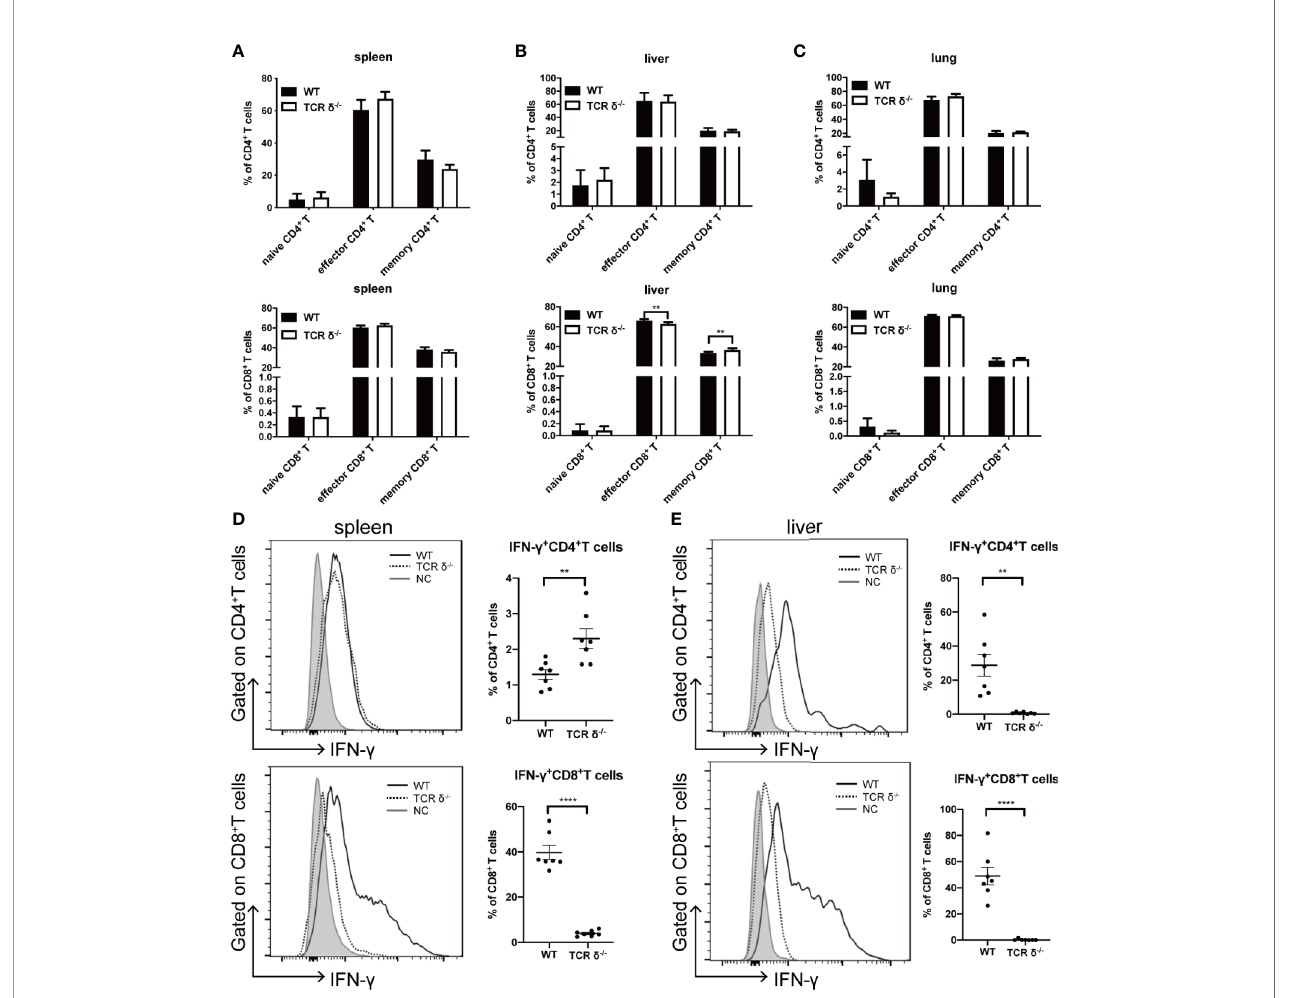
FIGURE 2 | Activation phenotypes and IFN- g production of CD4 + and CD8 + T cells in the recipients of WT or TCR d -/- grafts after allo-HSCT. The allo-HSCT was performed as described in Figure 1A . The lymphocytes were isolated from host spleen or liver on day 10 post allo-HSCT and analyzed by fl ow cytometry. Percentages of naïve, effector and memory CD4 + and CD8 + T cells in spleen (A) , liver (B) , and lung (C) were shown. The production of IFN- g by CD4 + and CD8 + T cells in the spleen (D) and liver (E) post allo-HSCT were examined (NC-Negative control: grey shaded, WT: solid line, TCR d -/- : dotted line). All data are representative of at least 3 independent experiments with n = 7 mice per group. All graphs display mean ± SEM. Signi fi cance was determined by unpaired 2-tailed Student ’ s t tests. ** p < 0.01, **** p <